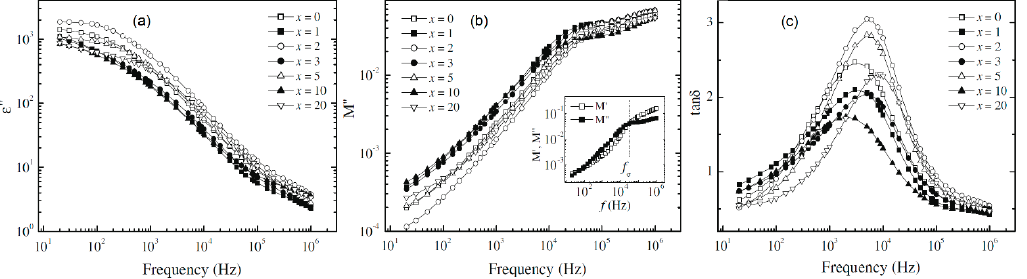
Figure 14. Frequency dependence of ( a ) dielectric loss ε ”; ( b ) electric modulus loss M ” and ( c ) loss tangent tan δ for CPEs of PEO (600,000 g/mol)–LiClO 4 (EO:Li + = 20)– x wt % MMT. Reproduced with permission from Choudhary [155]. Copyright 2013, National Institute of Science Communication and Information Resources (NISCAIR).